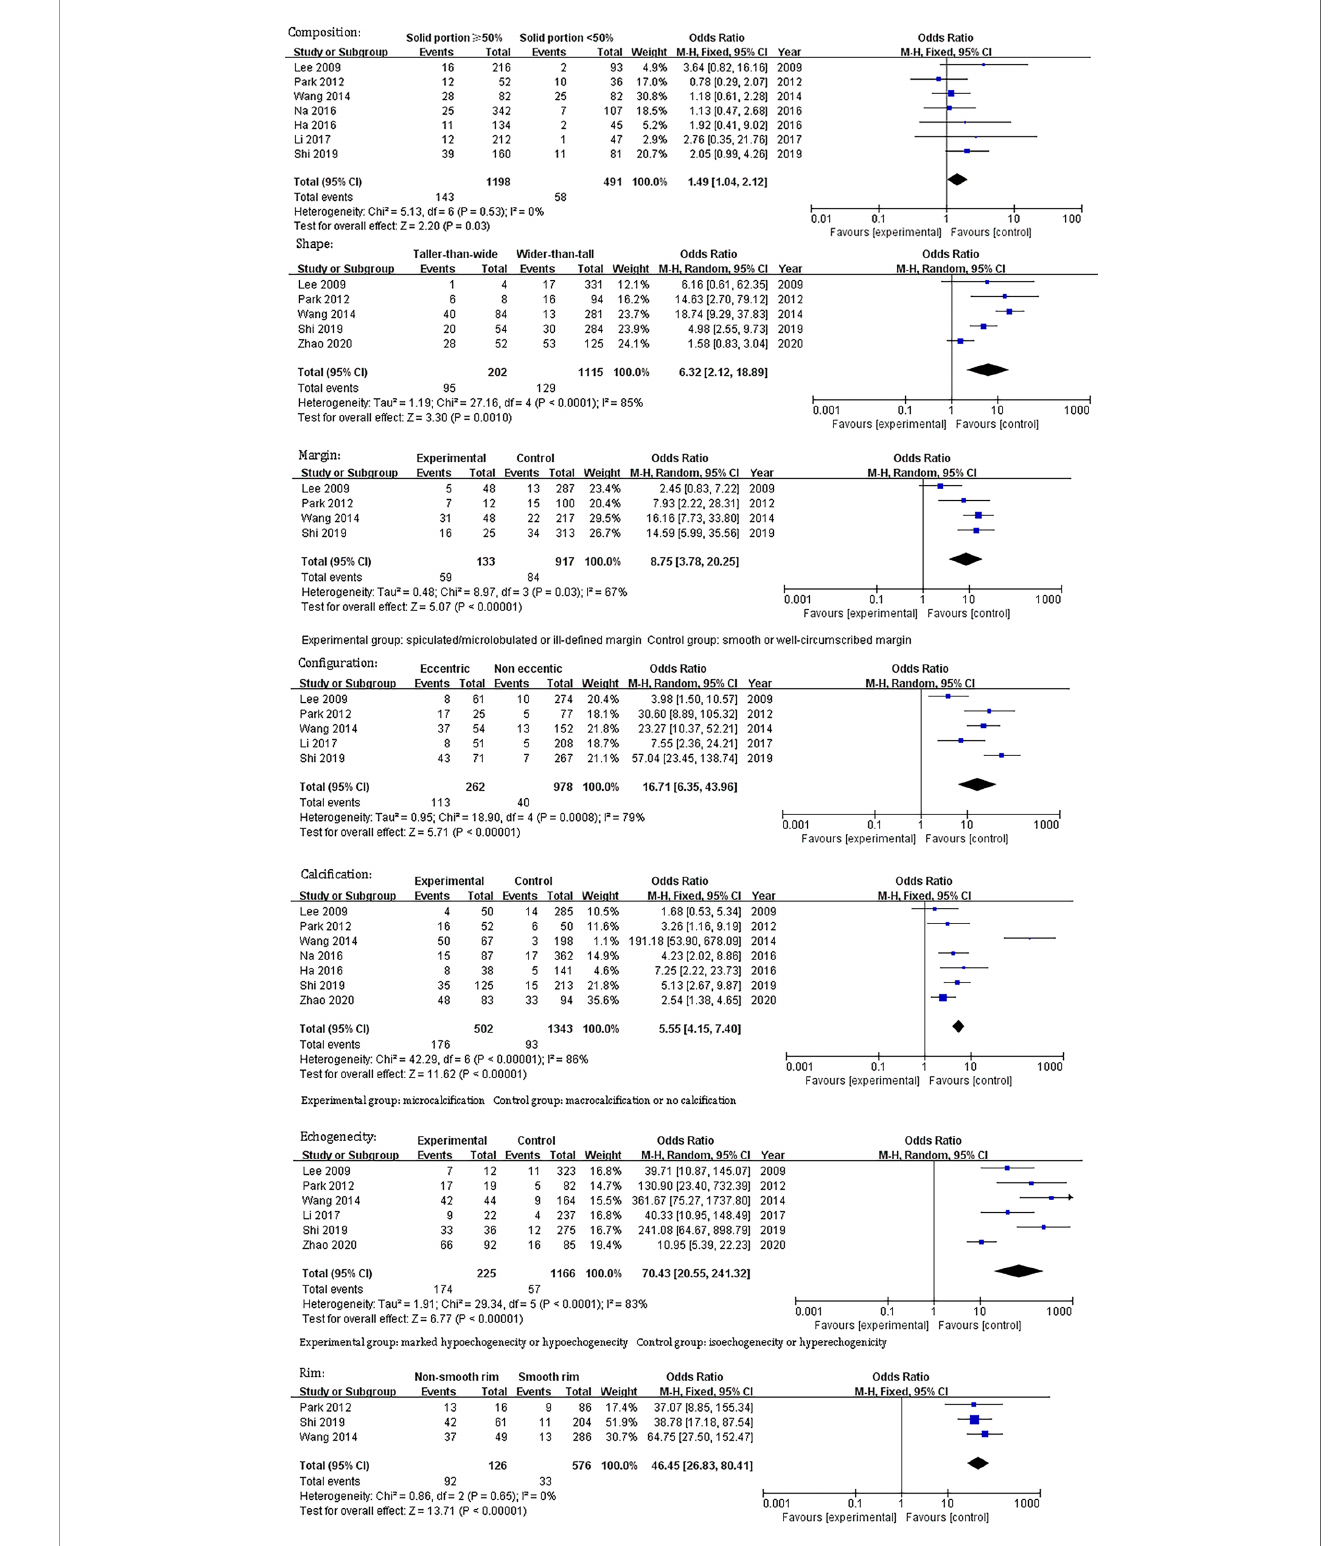
FIGURE 3 | Odds ratio and its 95% con fi dence intervals of seven sonographic features of partially cystic thyroid nodules.